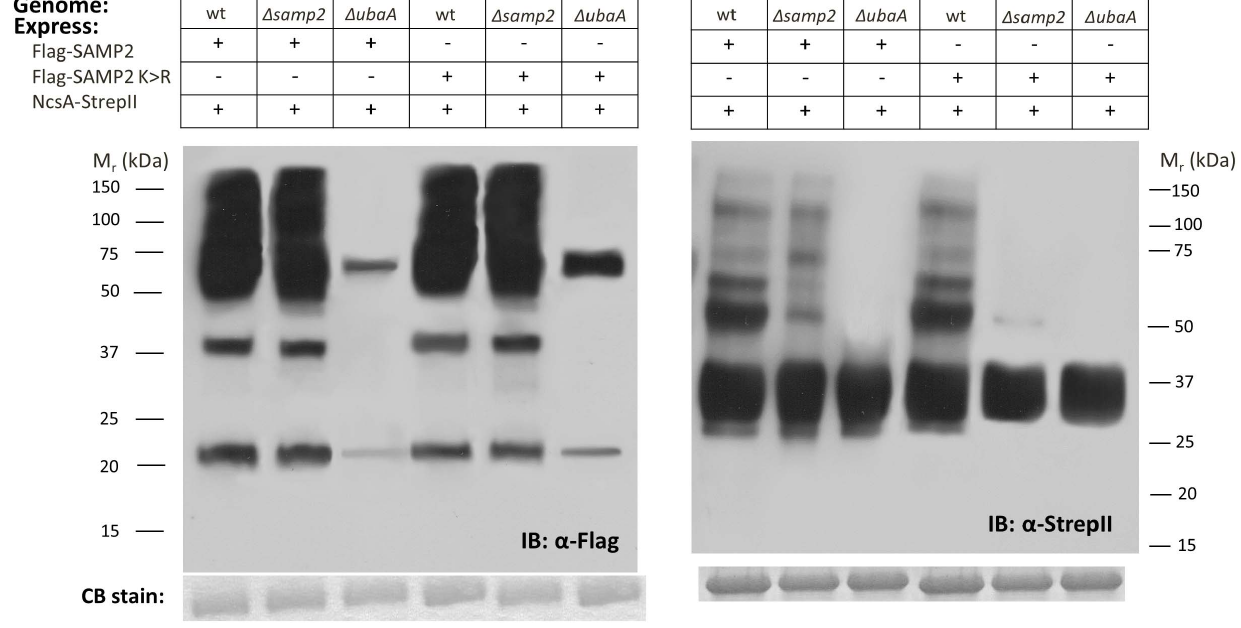
Figure 6. SAMP2 is covalently linked in apparent poly-SAMP2 chains to NcsA. NcsA-StrepII fractions purified from H26 (wt, parent), D samp2 , and D ubaA strains expressing NcsA-StrepII, Flag-SAMP2 and/or Flag-SAMP2 K . R variant were analyzed by IB [ a -Flag (left panel) and a - StrepII (right panel)] with molecular weight markers indicated on left and right of each panel, respectively. Coomassie blue stain (CB stain) was used to confirm equal protein loading. Pull down assays were from 50 ml cultures. See Methods section for details.